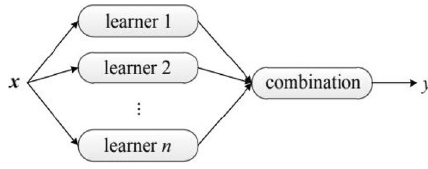
Figure 1. An ensemble architecture 5